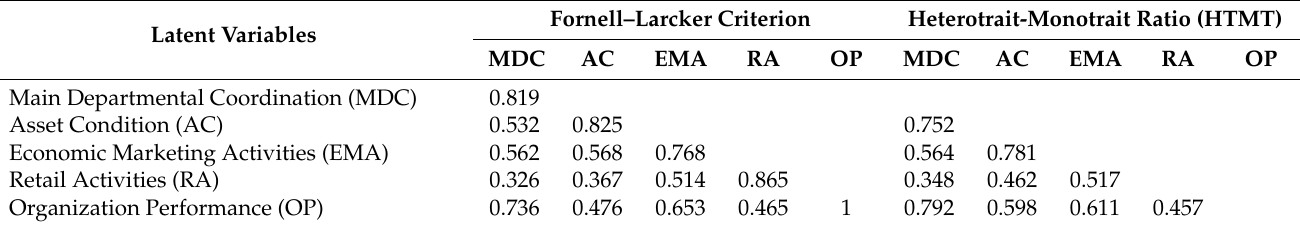
Table 3. Discriminant